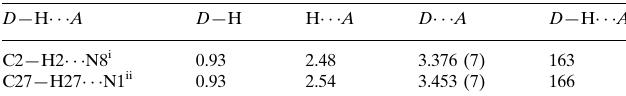
Hydrogen-bond geometry (A˚ , (cid:1)